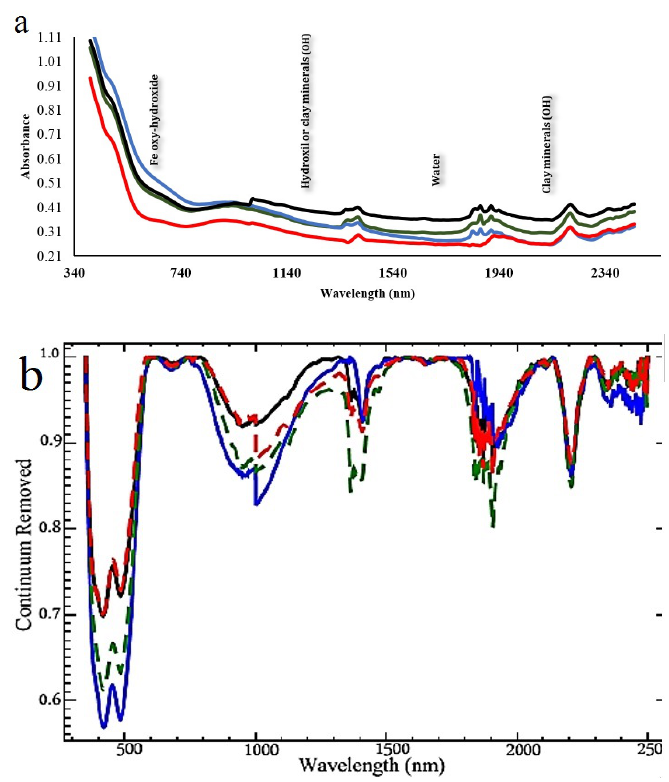
Figure 5. Raw absorbance ( a ) and continuum-removed ( b ) spectra of four randomly-selected soil samples.